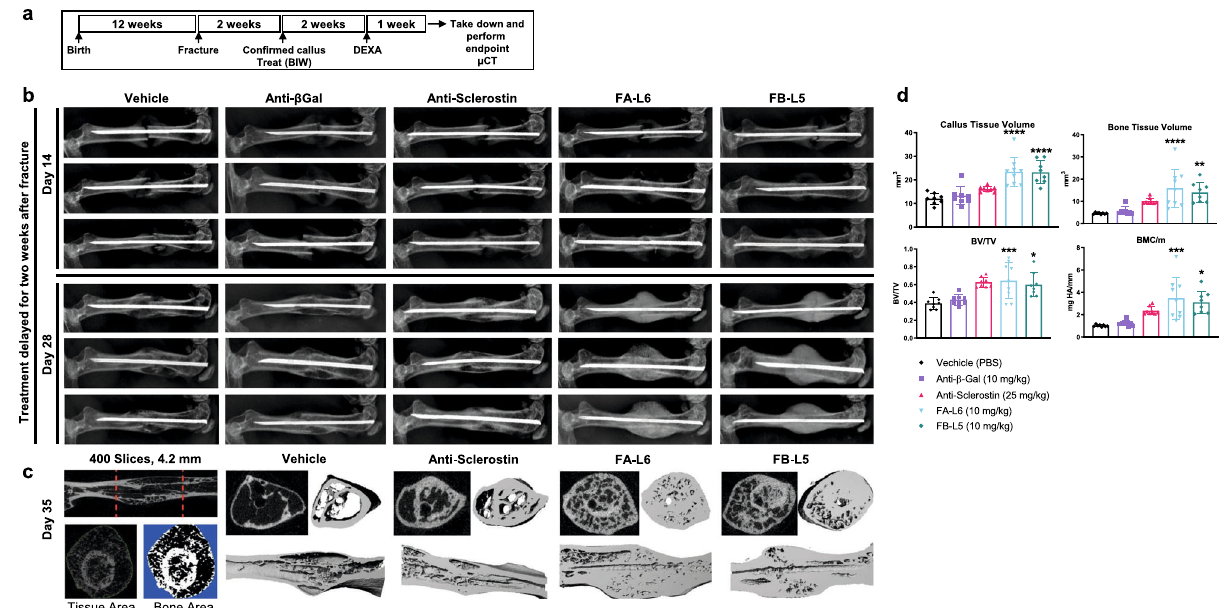
Fig. 8 Wnt mimetic antibodies increase bone accrual and bone repair when provided 2 weeks after fracture. a Schematic of experimental design. 12- week-old C57BL6/J female mice were surgically fractured adhering to the Einhorn fracture model. Animals did not receive any treatments for 2 weeks to allow for a normal cartilaginous callus to form. b Callus formation was visually con fi rmed by x-ray (top panel) at day 14; representative images ( n = 8 samples/group having similar results) demonstrate a small, but visible, callus with no cortical fusion. Mice were injected bi-weekly (BIW) for 21 days with intraperitoneal administration of FB-L5 (10 mg/kg), FA-L6 (10 mg/kg) and compared to a negative control anti- β -gal and bi-weekly subcutaneous administration of anti-sclerostin (30 mg/kg) antibody. Representative x-ray images demonstrate the large amount of cortical fusion and radiographic contrast present in the callus and marrow cavity of bones treated with FA-L6 and FB-L5 (bottom panel) at day 28. c Femurs were isolated at day 35 and scanned by µ CT. Measurements were made according to the left panel, where red dotted lines represent 4.2 mm, or 400 slices by µ CT, centered on the fracture line with image analysis shown for tissue area vs. bone area, and representative images shown for each treatment group. d Callus tissue volume, bone tissue volume, BV/TV, and bone mineral content/mm (BMC/mm) were measured for all animals at day 35. d Graphs represent mean values ± SD, n = 8 mice/group. Statistical signi fi cance was determined by one-way ANOVA (* p < 0.05, ** p < 0.01, *** p < 0.001, **** p < 0.0001), where the following letters de fi ne groups, (a = Vehicle, b = FA-L6, c = FB-L5). Callus tissue volume, a vs. b, p ≤ 0.0001, a vs. c, p ≤ 0.0001. Bone tissue volume, a vs. b, p = 0.0001, a vs. c, p = 0.0022. BV/TV, a vs. b, p = 0.001, a vs. c, p = 0.0116. BMC/mm, a vs. b, p = 0.001, a vs. c, p =